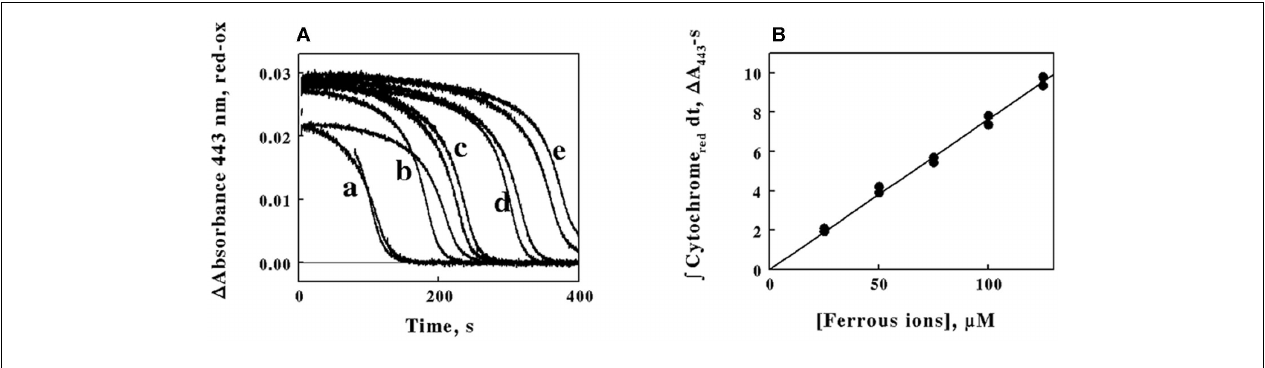
FIGURE 6 |The time integral of the absorbance of the reduced cytochrome in intact L. ferrooxidans correlates with the initial concentration of ferrous ions in the solution. (A) Time courses of the differences in the absorbance changes at 443nm on the initial concentration of ferrous ions. Cells of L. ferrooxidans (2.1 × 10 9 ) were